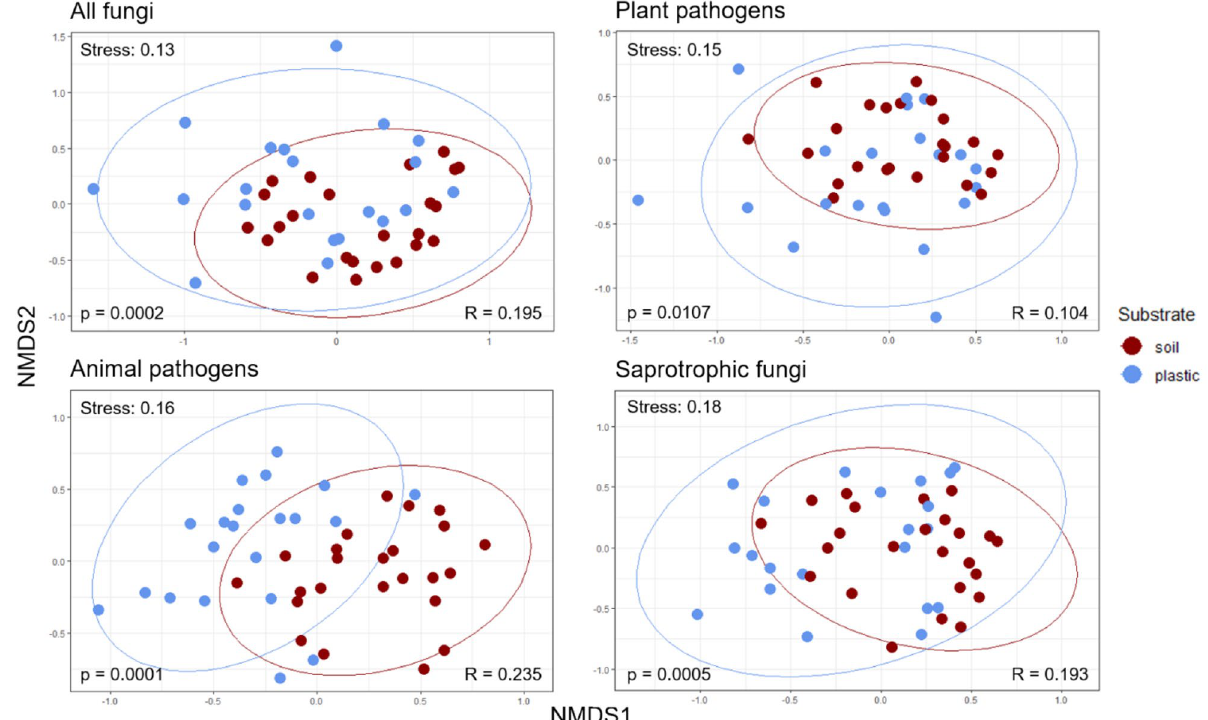
Figure 3. Variation in fungal community composition between plastic and soil visualised by NMDS. All four plots are based on Bray–Curtis dissimilarity matrices of square root transformed relative abundances of OTUs. Taxa subsets of the most dominant ecological guilds were compiled following meta-analysis and included only OTUs classified to genus or species level. Ellipsoids represent a 95% confidence interval surrounding the data points of each factor group. Significant variation between substrates was tested by PERMANOVA (included p-values) (Supplementary Table 4), while similarities within and between groups were additionally assessed using ANOSIM (sample statistic ‘R’) (Supplementary Table 6). NMDS ordination stress values